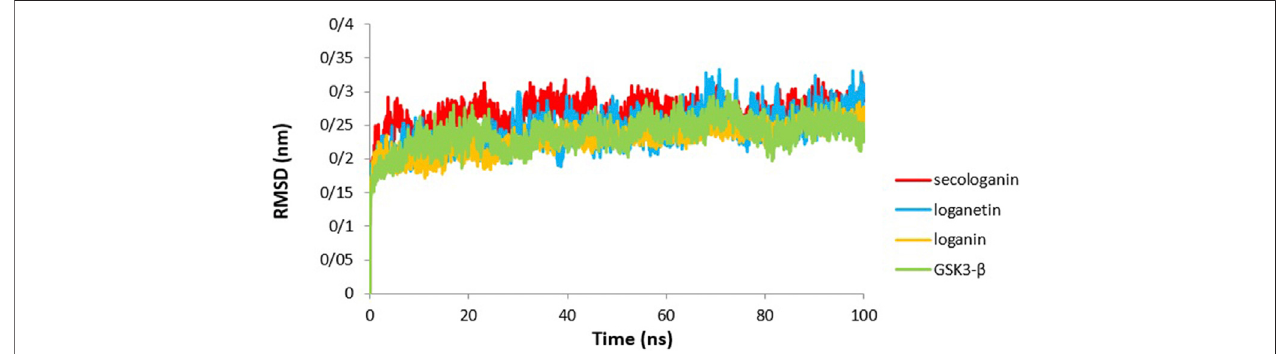
FIGURE8| RMSDanalysisGSK3- β protein(green),loganin-GSK3- β complex(yellow),loganetin-GSK3- β complex(blue),andsecologanin-GSK3- β complex(red).